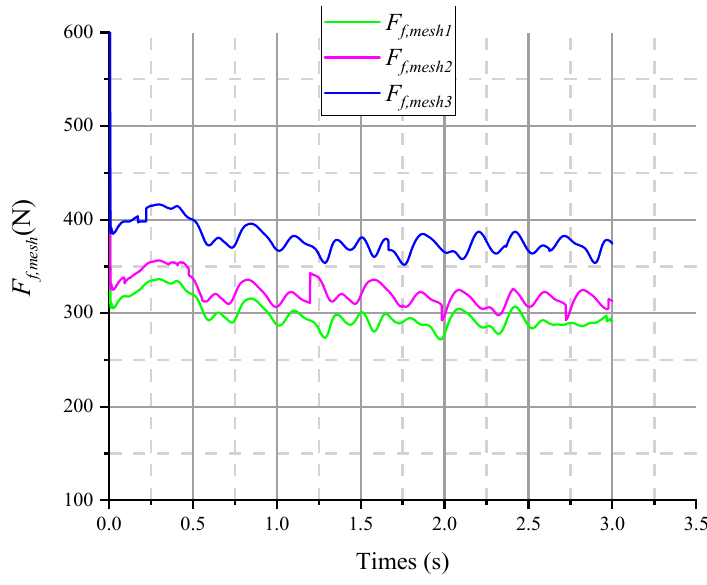
Figure 14. Convergence values of resistance under three kinds of grids. Finally, the mean resistance F f,mesh1 =300.4N, F f,mesh2 =321.2N, F f,mesh3 =378.1N. So there are: ,